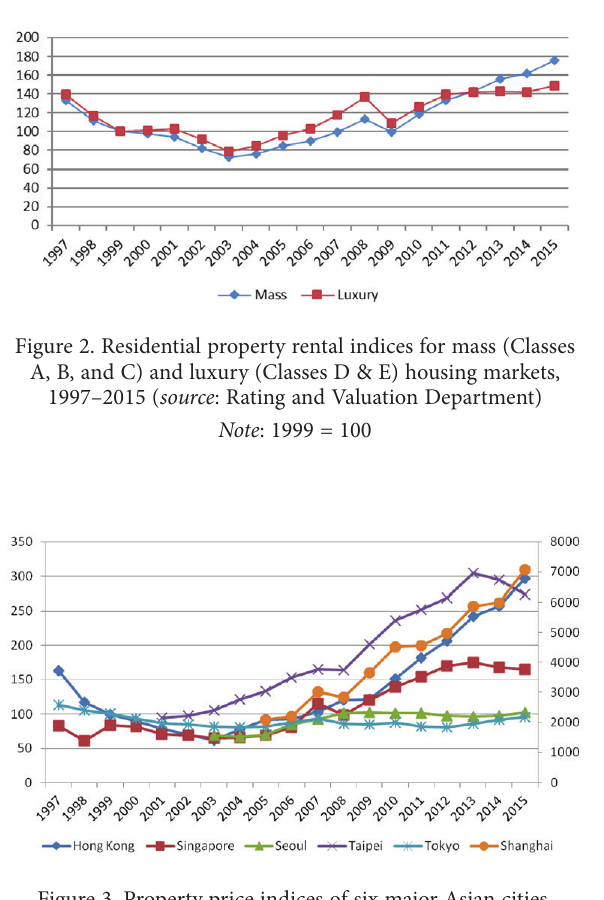
Figure 3. Property price indices of six major Asian cities,